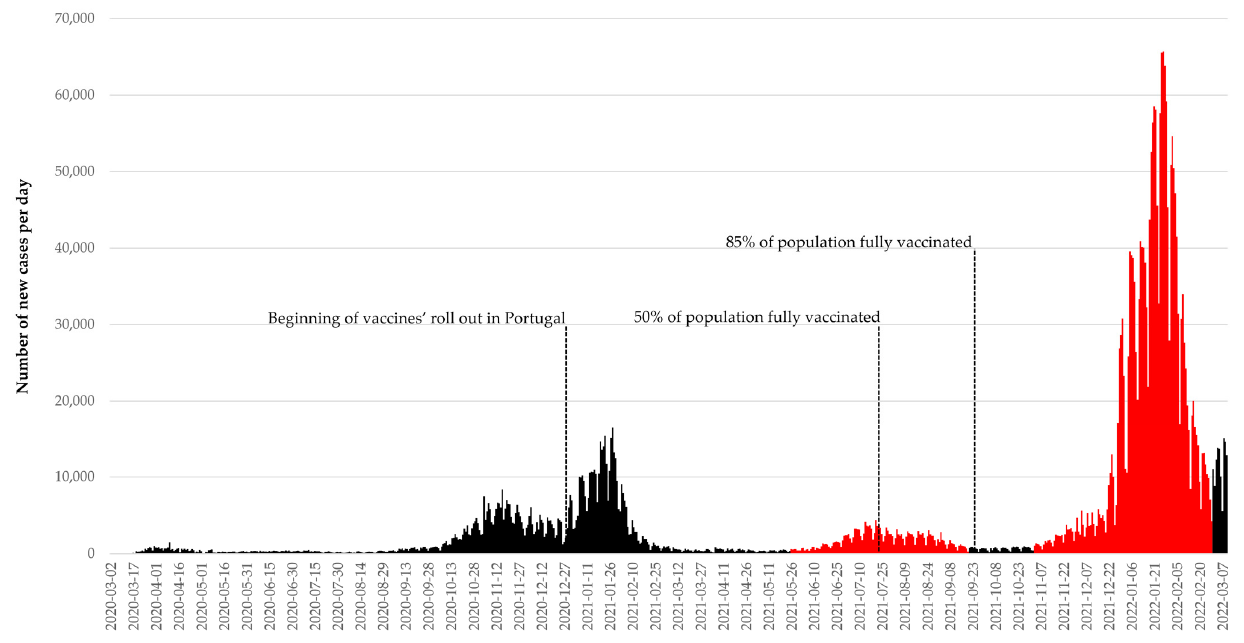
Figure 1. COVID-19 epidemic curve representing the evolution of the pandemic in Portugal. The periods for comparative analysis of COVID-19 vaccines effectiveness in this study are highlighted in red and correspond to the 4th and 5th pandemic waves.